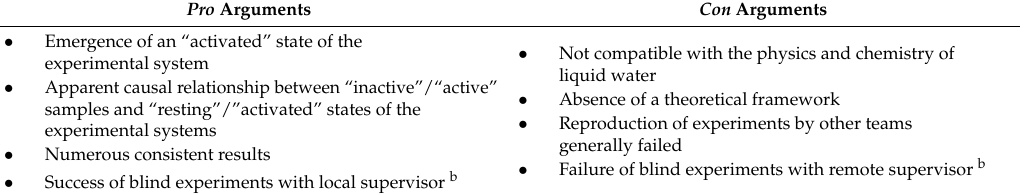
Table 1. The antagonistic pro and con arguments for molecular-like effects without molecules (“memory of water” a or “digital biology” a ) in Benveniste’s